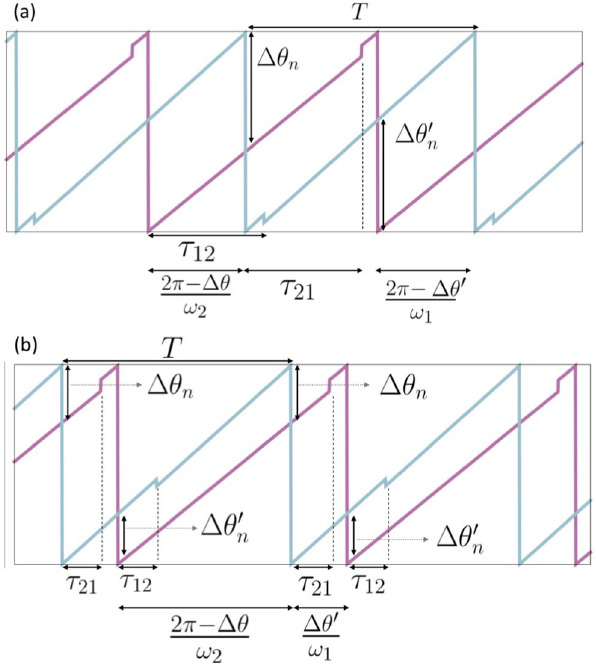
Fig. 1. Time evolution of coupled phase oscillators. (a) Time evolution of two bi-directionally coupled phase oscillators for D h * p . (b) Time evolution of two bi-directionally coupled phase oscillators for D h * 0 . T is the period of the oscillators in the phase-locked state and t ij is the delay time from pre-synaptic neuron j to post-synaptic neuron i . D h n ( D h ’ n ) is the phase difference (modulo 2 p ) of two neurons at the n th spiking time of first (second)